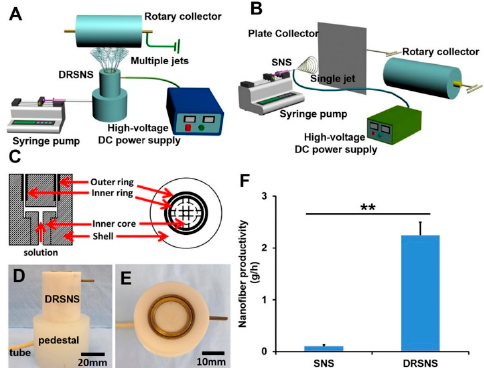
Figure 2. Schematic diagrams of ( A ) the double-ring slit needleless spinneret (DRSNS) setup, ( B ) single needle electrospinning setup, and ( C ) diagram of the internal structure of the DRSNS apparatus, photographs of DRSNS from ( D ) front view and ( E ) top view, and ( F ) a plot showing comparison of nanofiber productivities of DRSNS- and single needle spinneret (SNS)-based electrospinning systems. [Adapted with permission from 40. Copyright (2019) American Chemical Society].